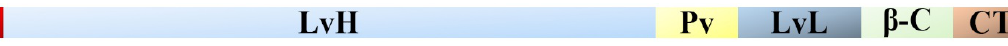
Figure 1. Schematic summary of structure of a complete teleost vitellogenin (Vtg). A short signal peptide (SP) is shown at the N -terminus, flowing by a lipovitellin heave chain (LvH), a phosphorylated serine-rich phosvitin (Pv), a lipovitellin light chain (LvL), and a β -component ( β -C) plus a C -terminal coding region (CT).